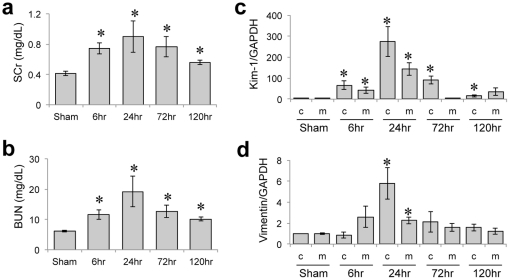
Temporal profiles of kidney biomarkers in ischemic-reperfusion kidney model.
A. SCr levels are measured after 6 hr, 24 hr, 72 hr, and 120 hr of reperfusion after I/R injury in rat. Significant difference of SCr level compared to Sham is shown with asterisk (P<0.05). B. The temporal changes in BUN levels are shown. Renal mRNA levels of Kim-1 (C) and Vimentin (D) are shown for cortex and medulla. The mRNA levels were normalized using GAPDH as control gene (denoted as c and m, respectively). * represents P<0.05 as determined by one way ANOVA in comparison with sham rats.